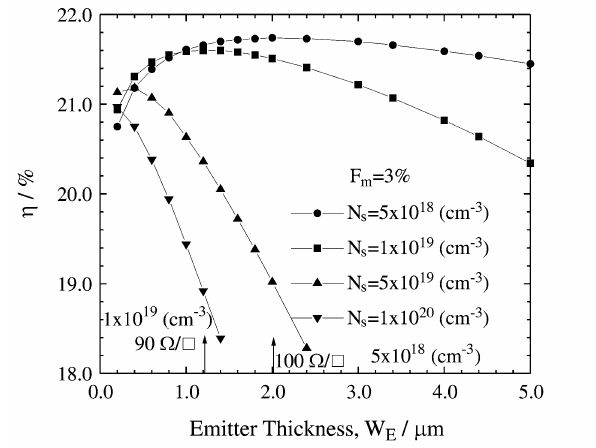
Figure 6. Solar cell efficiency ( η ) as a function of emitter thickness (W E ), considering different surface doping levels (N s ). The arrows indicate the emitter sheet resistance.